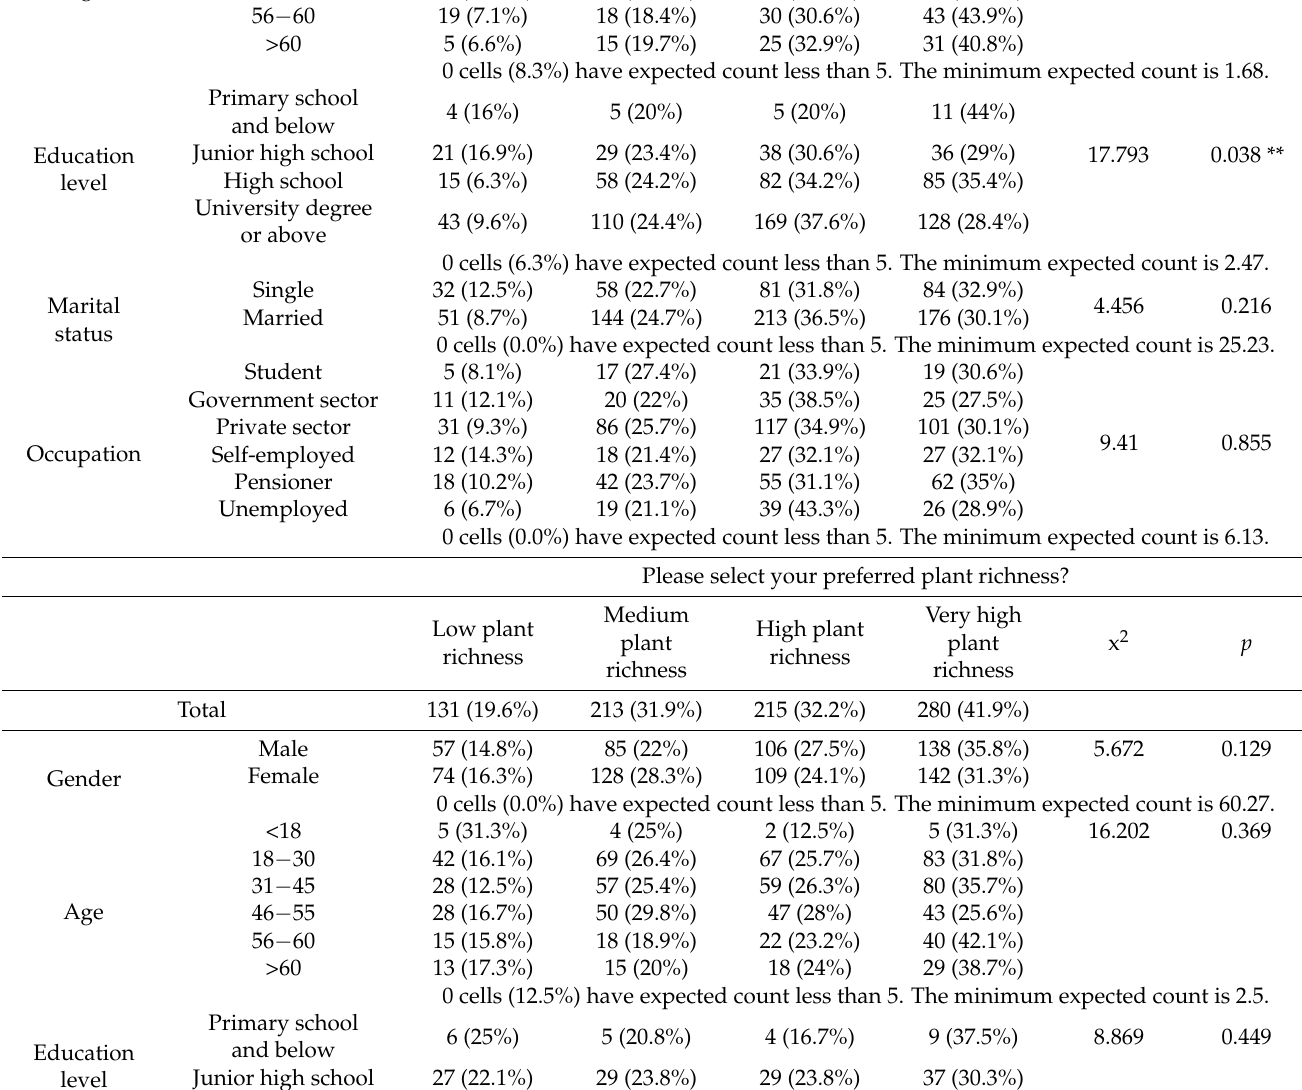
Please Select Your Preferred Planting Pattern? Tree Planting